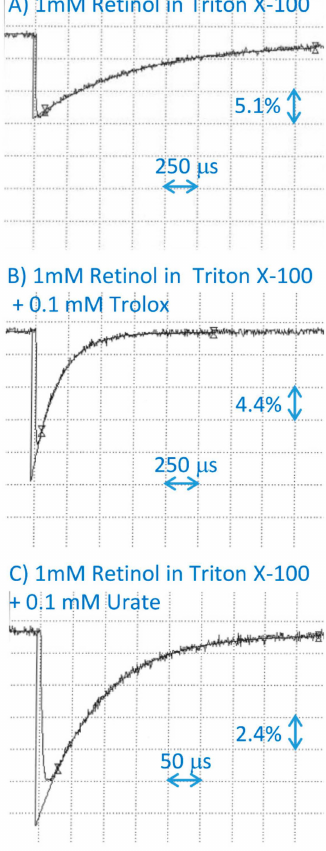
Figure 6. Representative kinetics of the formation and decay of retinol cation radicals monitored at 590 nm after pulse radiolysis of aqueous solution saturated with N 2 O and containing 10 mM of phosphate, pH 7, 0.1 M of KBr, and 1 mM of retinol incorporated in 2% Triton X-100 micelles, in the absence ( A ) and presence of 0.1 mM of Trolox ( B ) or uric acid ( C ). Urate scavenged retinol cation radicals in micelles with the bimolecular rate constant of − 1 · − 1 1.1 × 10 8 M s (Figure 6; Table 1), which is the same within the experimental uncertainty as the rate of scavenging by ascorbate